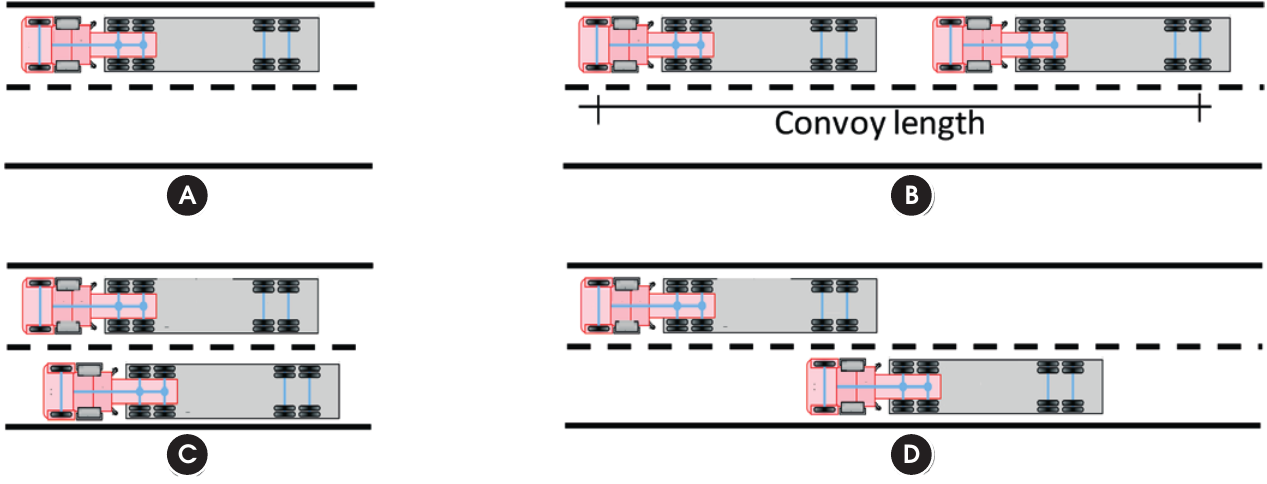
Traffic loading patterns – Gindy and Nassif